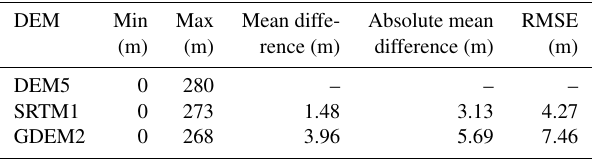
Table 1. Statistics of elevation differences between global